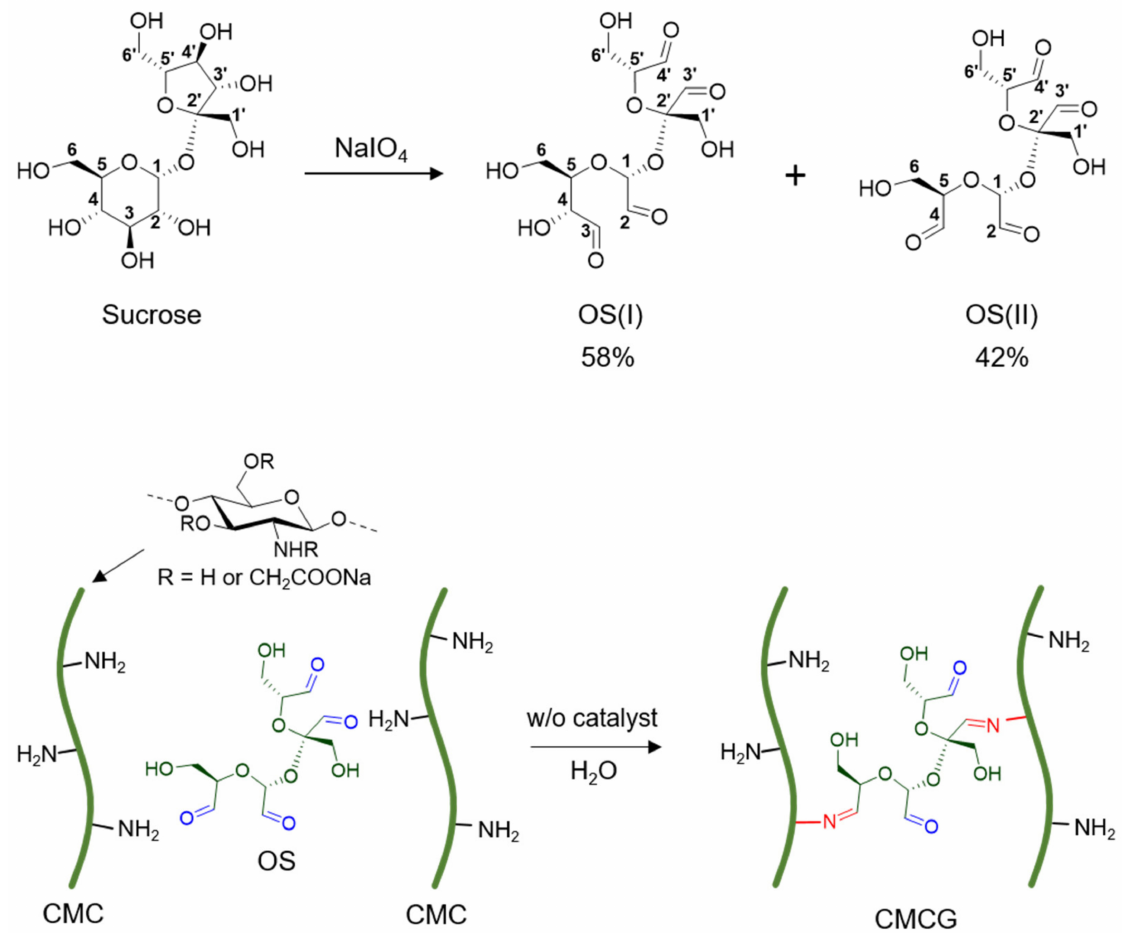
Figure 1. Schematic outlines of the preparation of oxidized sucrose (OS) from sucrose using sodium periodate (NaIO 4 ) (top) and the carboxymethyl chitosan hydrogels (CMCG) from carboxymethyl chitosan (CMC) using oxidized sucrose (OS) as a cross-linking agent